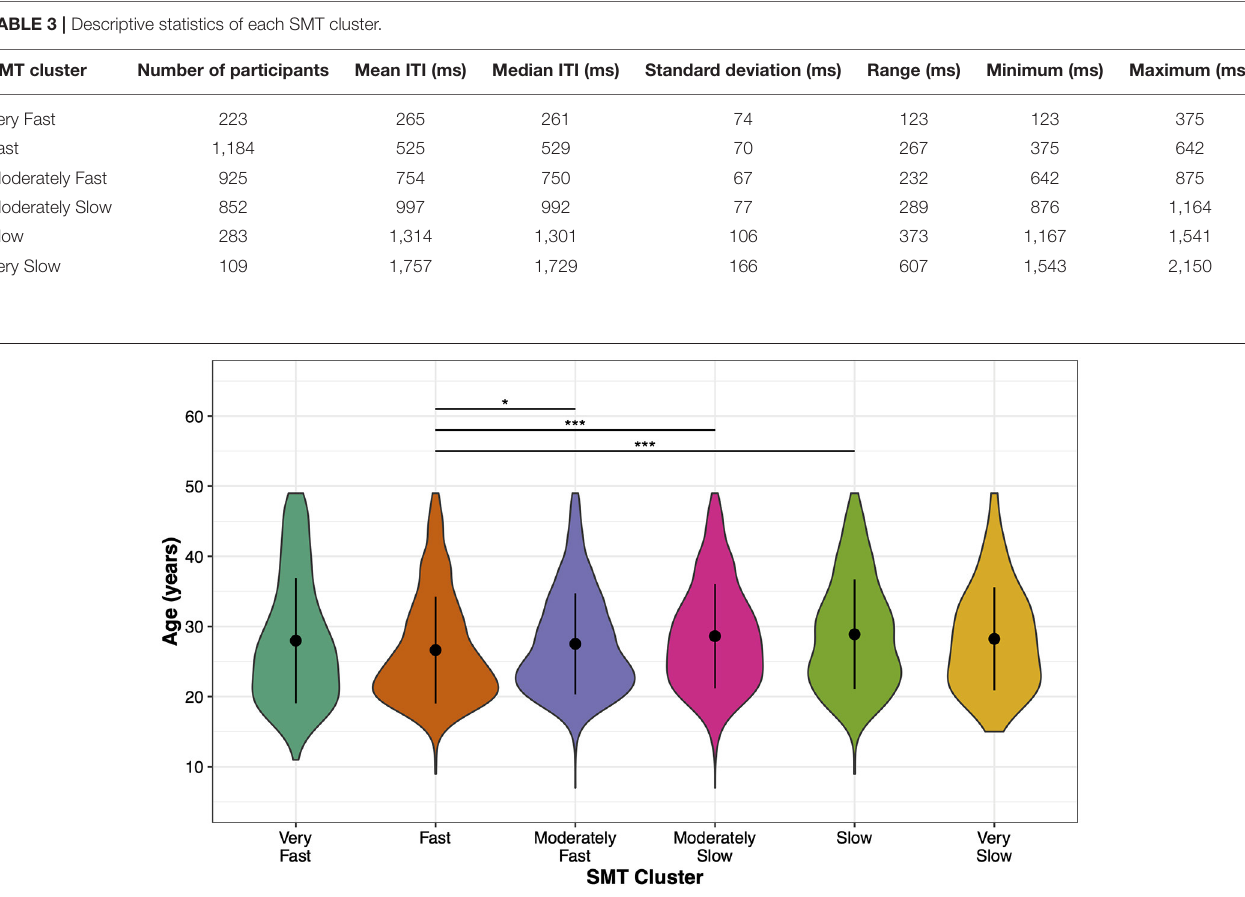
FIGURE 2 | Age distribution between SMT clusters. Mean values (black points) and standard deviations (error bars) of participants’ age for each SMT cluster. Colored areas show the age distribution. Asterisks indicate significant differences: * p < 0.05, ** p < 0.01, and *** p < 0.001.